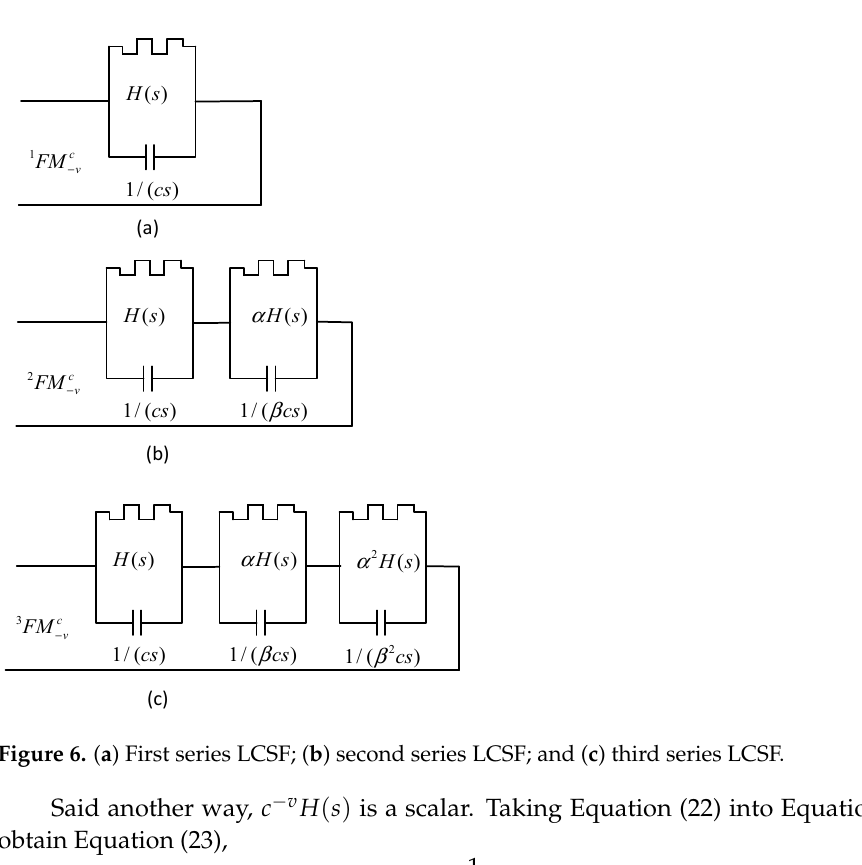
Given that the transition probability series in FMAC is similar in structure and function to the physical LCSF system, the circuit of LCSF is used to predict the transition probability flow i in in the